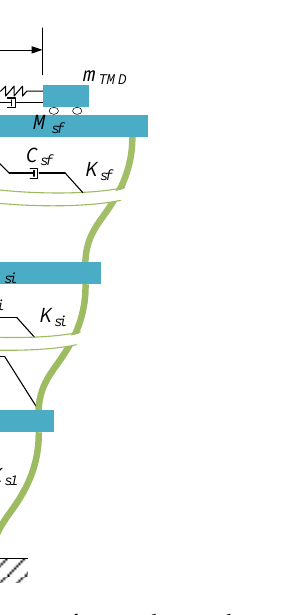
Figure 5. Schematic diagram of a tuned mass damper (TMD) attached to the building top.